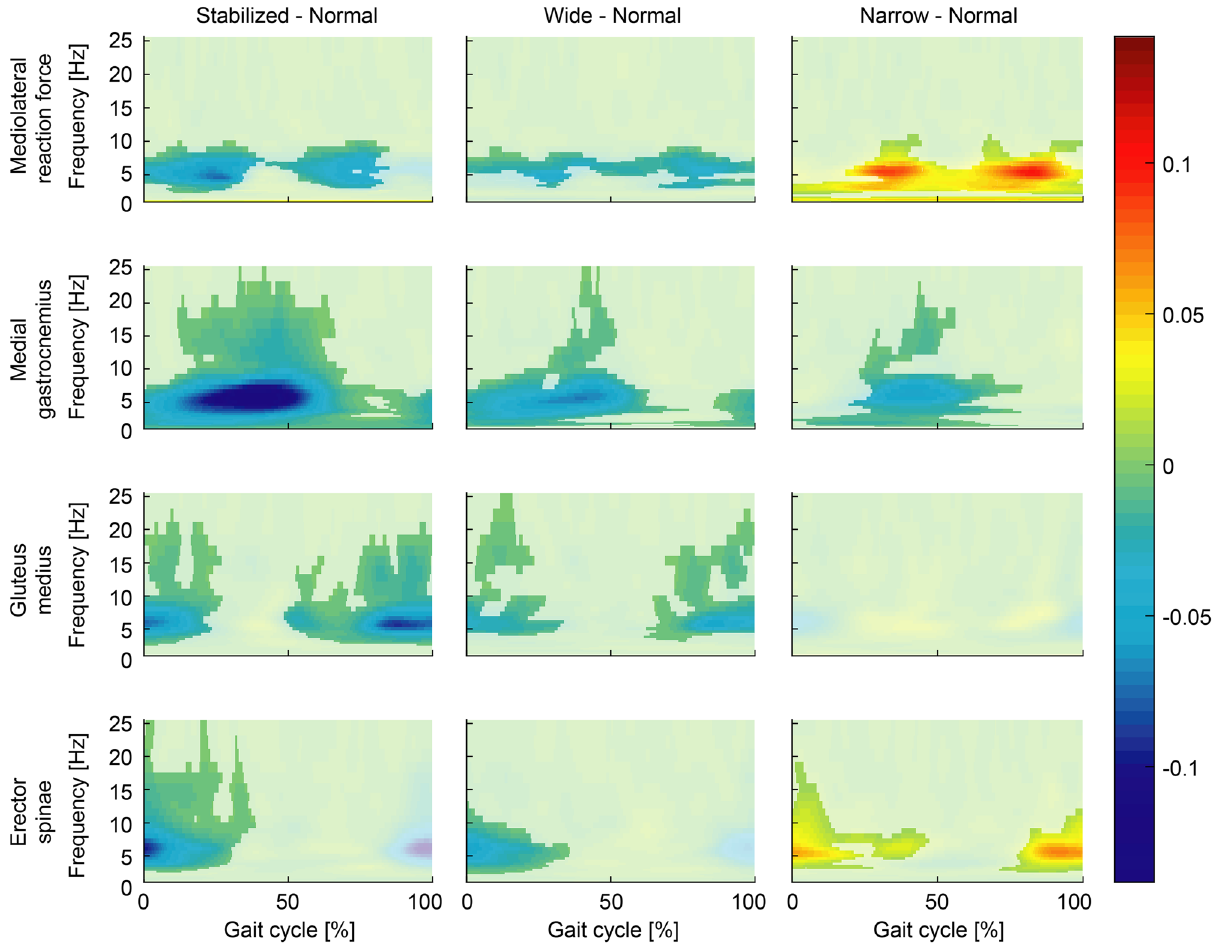
Figure 5. Differences in time–frequency coherence between the normal walking condition and walking with external lateral stabilization (first column), wide-base walking (second column) and narrow-base walking (third column). Color coding refers to the difference in coherence between two walking conditions (e.g. normal minus stabilized) for the EVS-GRF coherence (first row) and EVS-EMG coherence of medial gastrocnemius (second row), gluteus medius (third row) and erector spinae (forth row) muscles. For illustrative purposes, differences that were not significant were plotted slightly